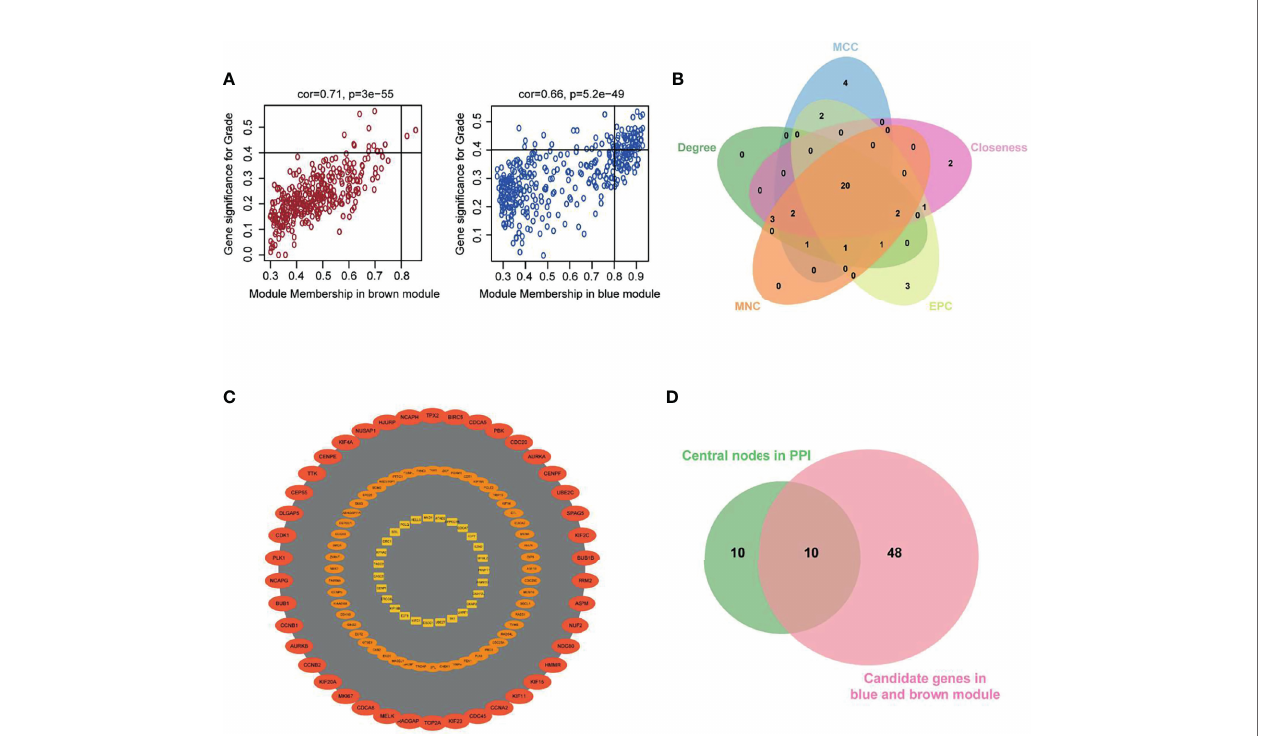
FIGURE 5 | Investigation of hub genes in the Blue and Brown modules. (A) Scatterplots of GS for neoplasm histologic grade (y-axis) versus MM (x-axis) in the two modules. (B) Key nodes were analyzed by CytoHubba using the following fi ve methods: Closeness, Degree, edge percolated component (EPC), Maximum neighborhood component (MCC), and Maximum Neighborhood Component (MNC). (C) The most signi fi cant module obtained from the PPI network (MCODE score = 105.433). (D) Venn diagram demonstrated overlapping genes of the WGCNA and PPI